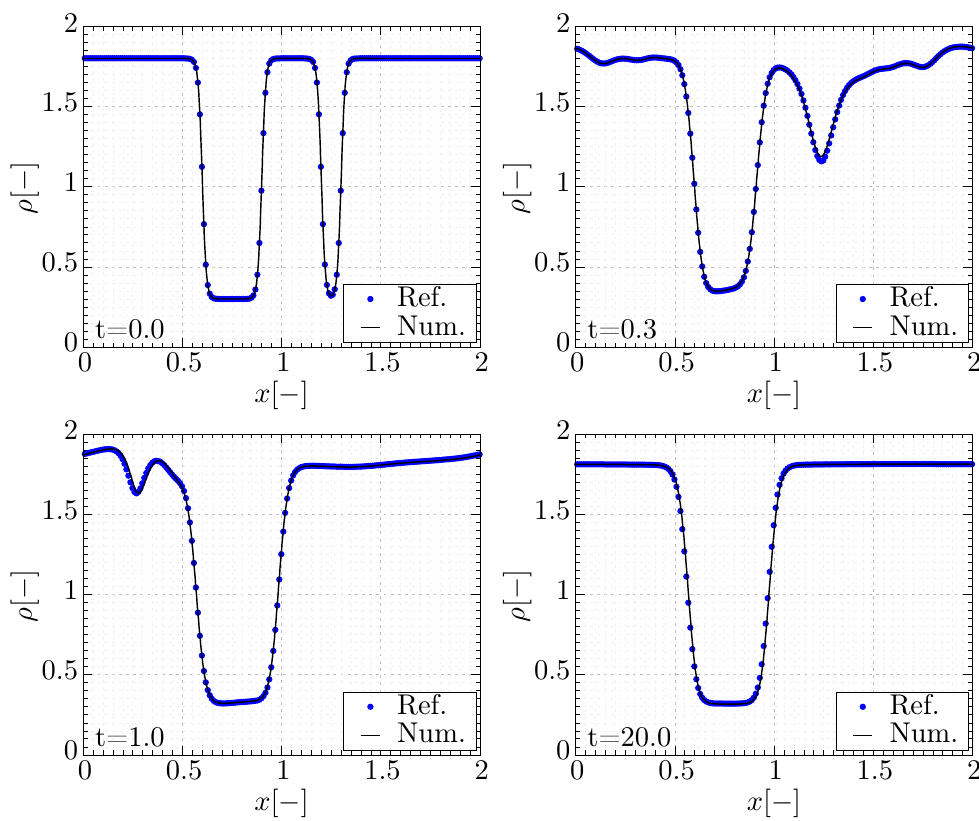
Figure 3. Density profile for the 1D Ostwald ripening simulation plotted at four different times 0,0.3,1,20 obtained by our scheme (Num, black line) and compared against a reference t ∈ { } numerical solution (Ref, blue dots) obtained using an ADER-DG P 3 P 3 method presented in [32]. Parameters used for this simulation are γ = 10 − 3 , µ = 10 − 2 , c s = 10, α = 10 − 2 and β = 10 − 5 . The domain is discretized over N x = 4096 cells.